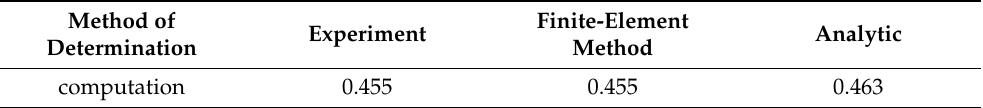
Table 1. Deflection of the translucent element under pressure of 10 MPa.